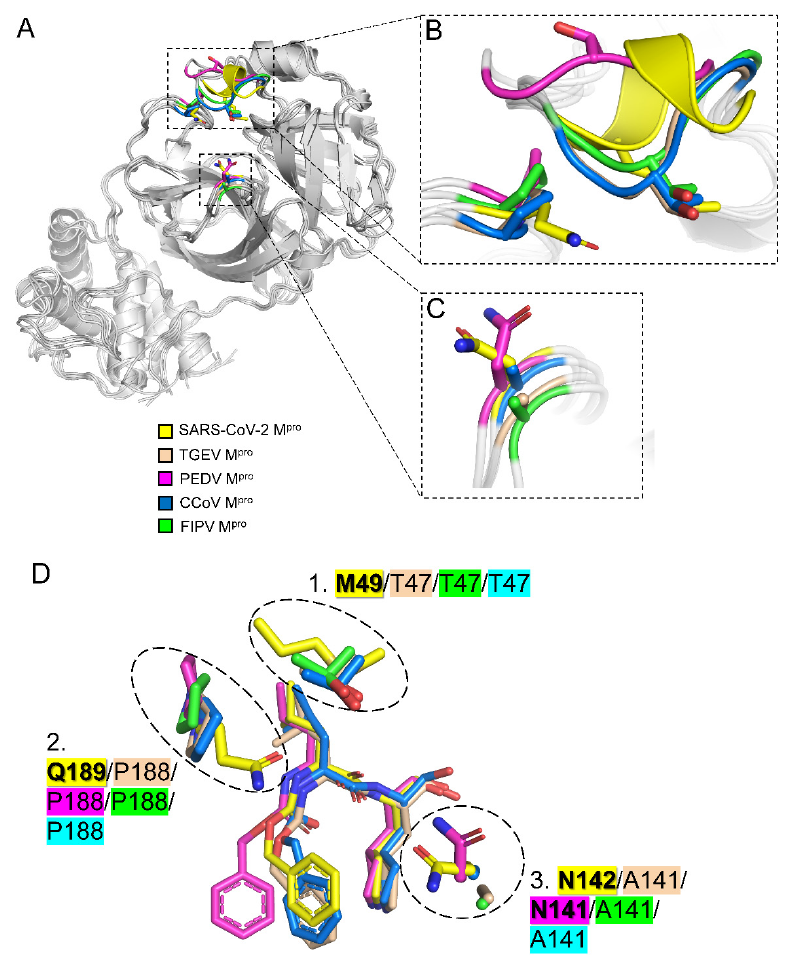
Figure 4. Structural comparison between animal CoV M pro s and SARS-CoV-2 M pro : ( A ) Overall structural comparison of SARS-CoV-2 M pro (PDB: 7CB7), TGEV M pro (PDB: 4F49), PEDV M pro (PDB: 6L70), CCoV M pro , and FIPV M pro (PDB: 5EU8). Three structural differences have been highlighted; ( B ) an enlarged view of the first (loop/ α -helix) and second (P188/Q189) structural differences highlighted in ( A ); ( C ) an enlarged view of the third (A141/N142) structural differences highlighted in ( A ); ( D ) the three structural features of CoV M pro s that differentially contribute to recognition of GC376.